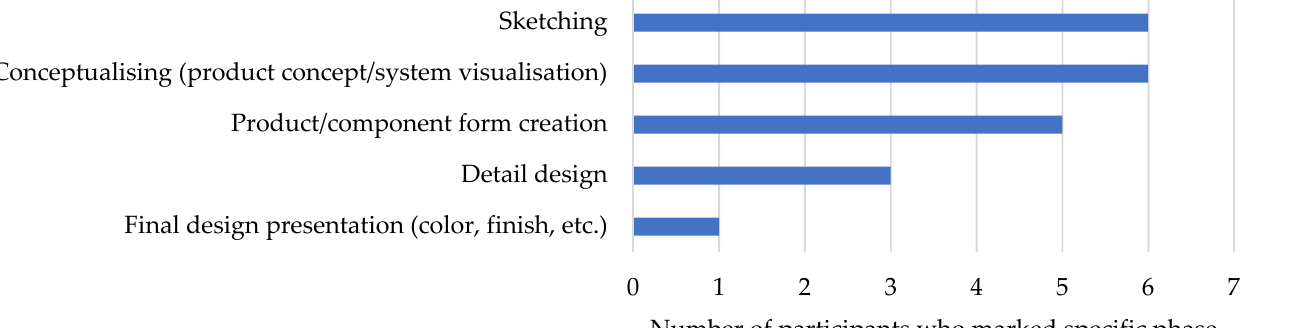
Figure 11. Participants’ opinions on the use of VR technology in different design phases.